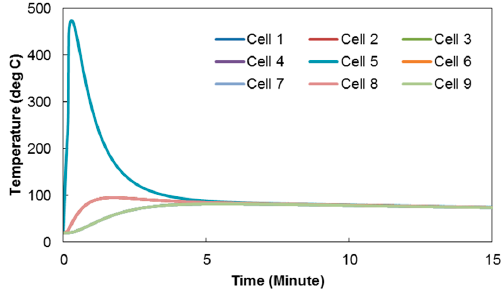
Figure 8. Temperature change of cells in the battery module.